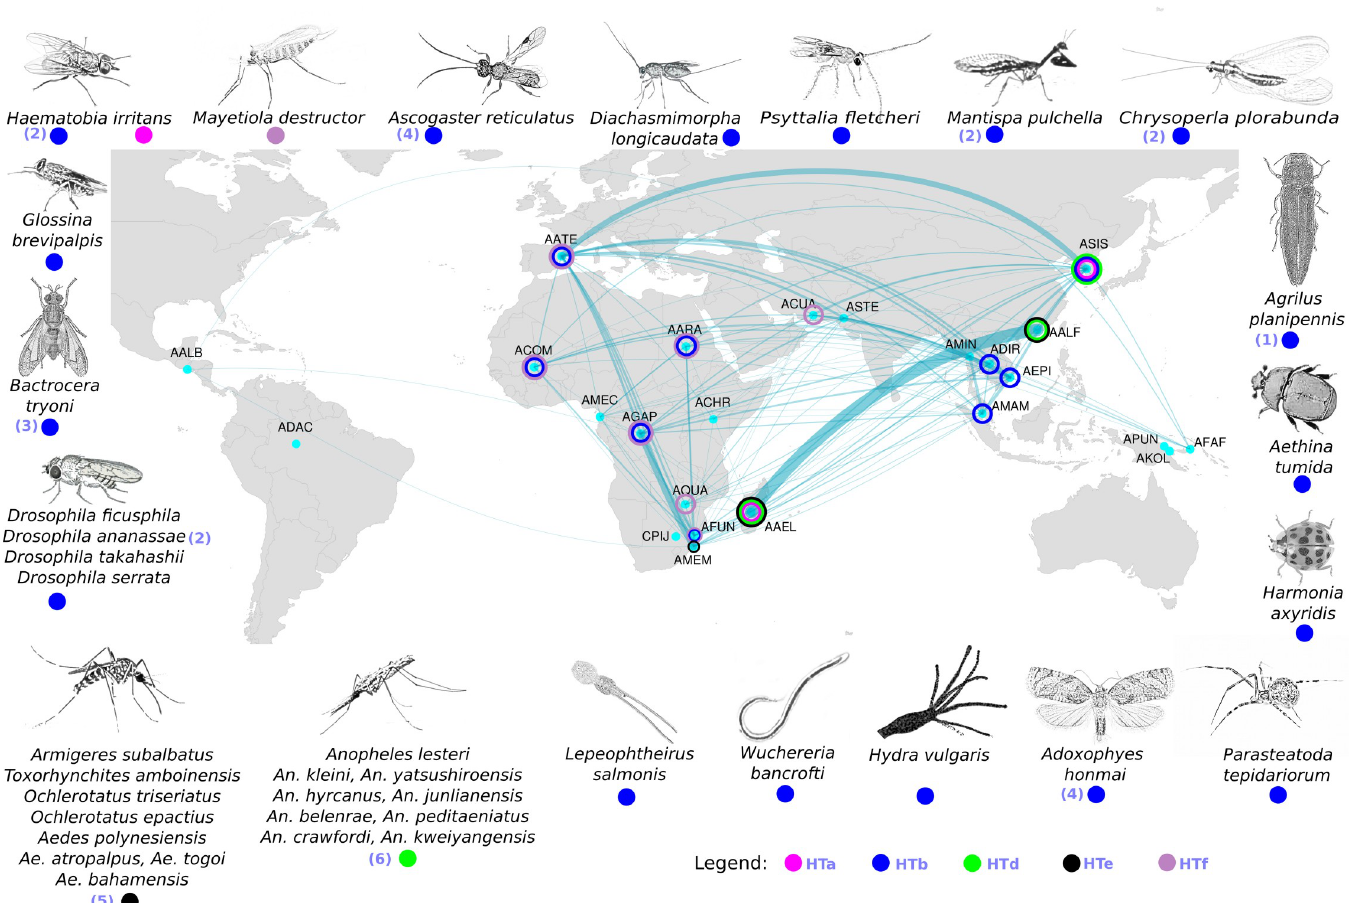
Fig 5. Mosquito HTT network from a geographical perspective. Light blue dots represent the species sampling site for the genomes used in this study or the most probable site of a species origin. The edges connecting dots represent significant pairwise HTT events, the thickness of those edges is proportional to the number of HTT events. Five out of 172 TEs are horizontally transmitted to other species outside the group of 24 studied species, these TE families are represented by colored circles: HTa (pink), HTb (blue), HTd (green), The (black), and HTf (light purple). The species involved in a horizontal transfer with at least one of the 24 mosquitoes are shown in the map border. The colored circle around light blue dots indicates that this mosquito species is involved in a long-range HTT network of at least one specific TE (HTa to HTf). The numbers inside the round brackets represent some preliminary evidence of HTTs involving these TEs and species in other published articles. 1 represents the APmar1 element already described by Rivera-Vega et al. [105], 2 represents HTT transfers among species described by Robertson and Lampe [106], 3 represents an element described by Green and Frommer [107], 4 represents HTT transfer between Ascogaster reticulatus and Adoxophyes honmai [108], 5 represents HTT events already described in mosquitoes [109], 6 represents HTT events already described in other Anophelinae species [110] not investigated in our study.